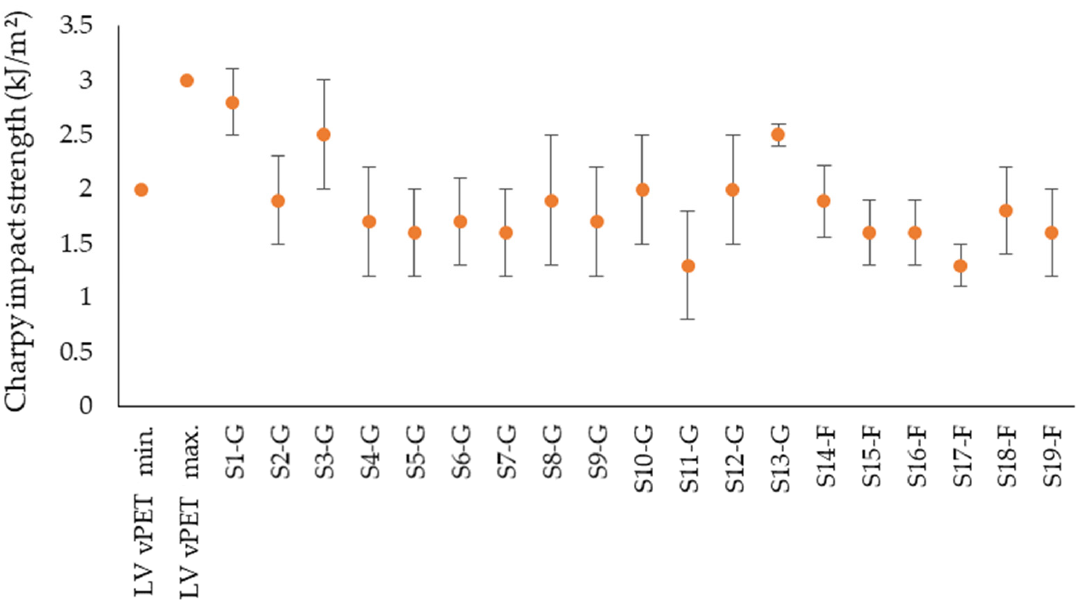
Figure 10. Impact strength of rPET samples in comparison with literature values for vPET.